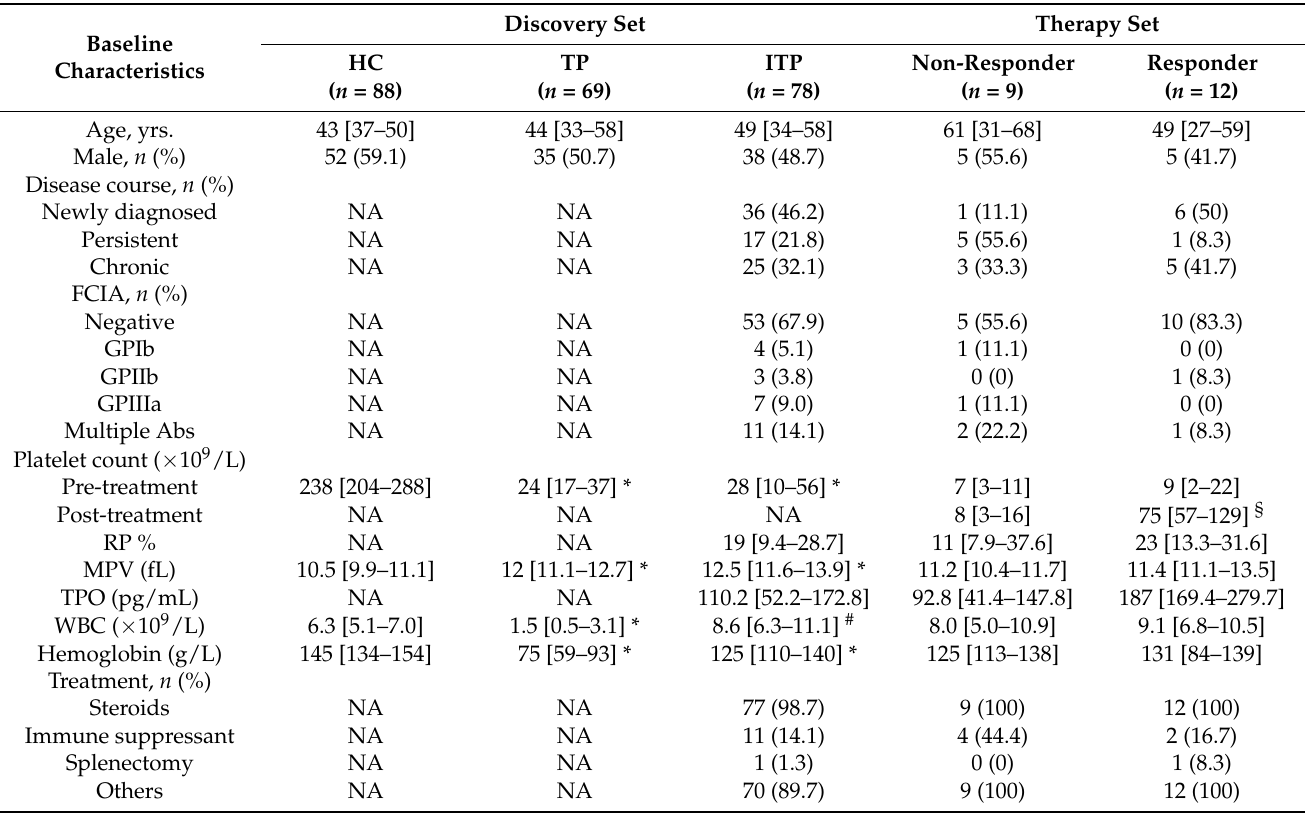
Table 1. Characteristics of the study participants.